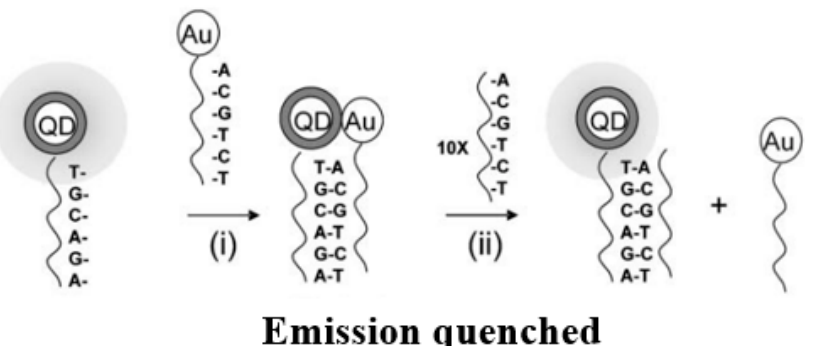
Figure 4. Schematic diagram of QD–DNA biosensor. (i) Addition of 1 equivalent of the Au-DNA to the QD-DNA to yield the hybrid, (ii) Addition of 10 equivalents of the unlabelled complementary oligonucleotide to the hybrid [58].